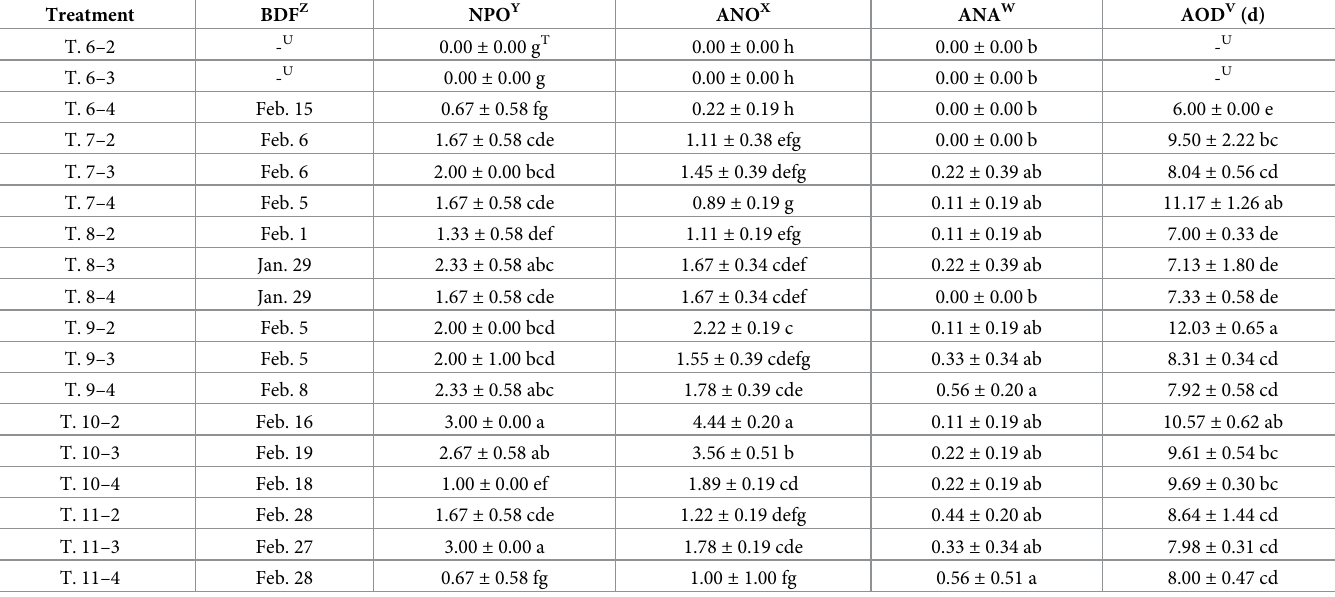
Z BDF : the Beginning Date of the first Flower opening Y NPO: Average Number of Plants per replicate with Opening flower X ANO : Average Number of Opening flowers per plant W ANA : Average Number of Aborted flowers per plant V AOD : Average Opening Days per flower U All plants of the Tre. 6–2 and 6–3 never bloomed or have aborted flower, so the partial data were unable to be collected